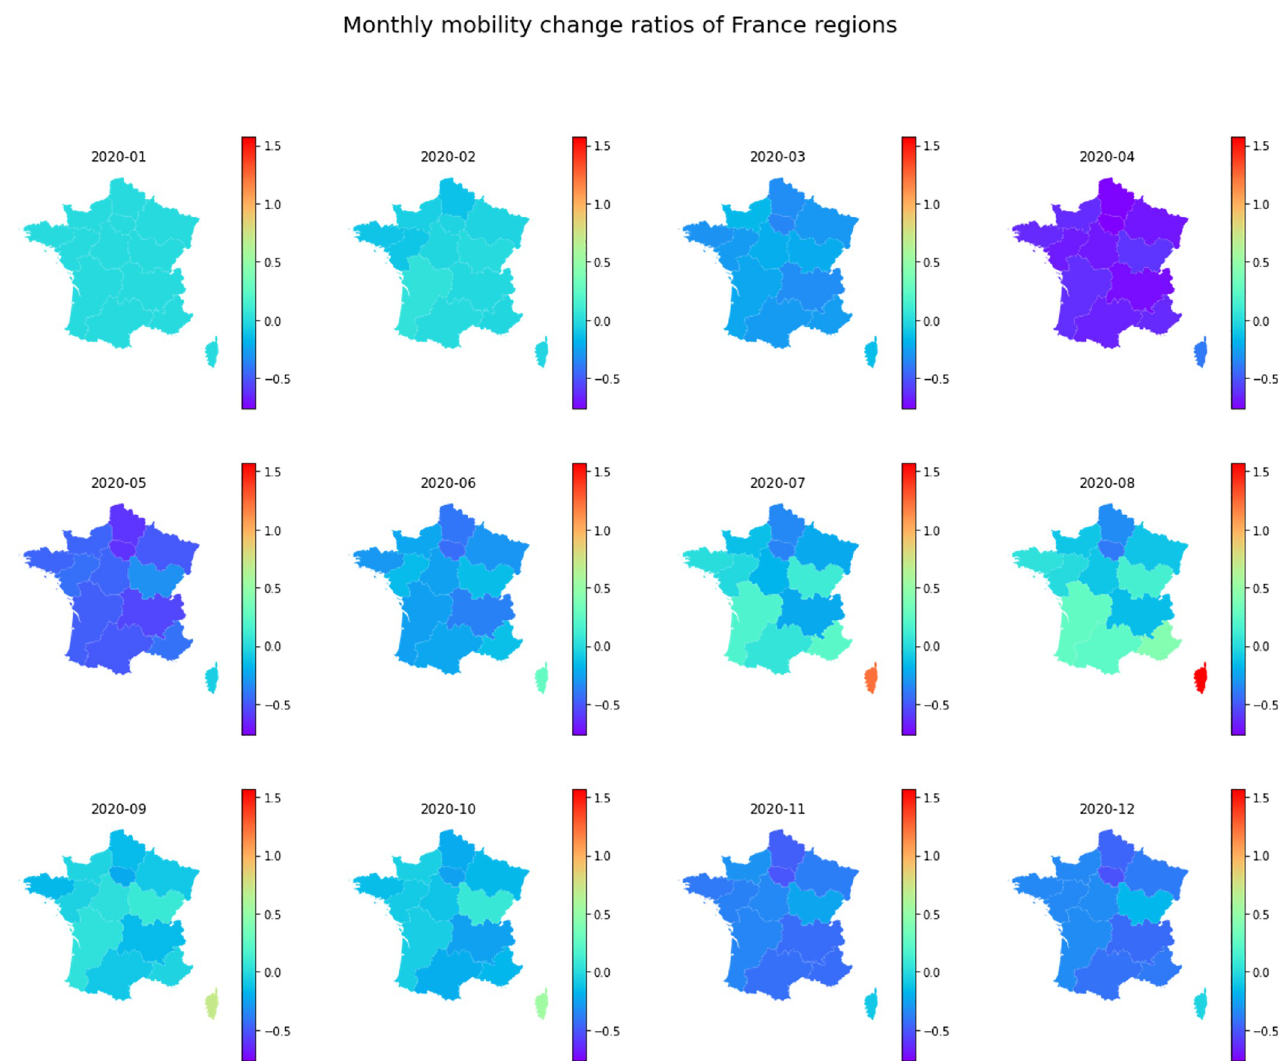
Fig 14. Monthly mobility change rates in 13 French administrative